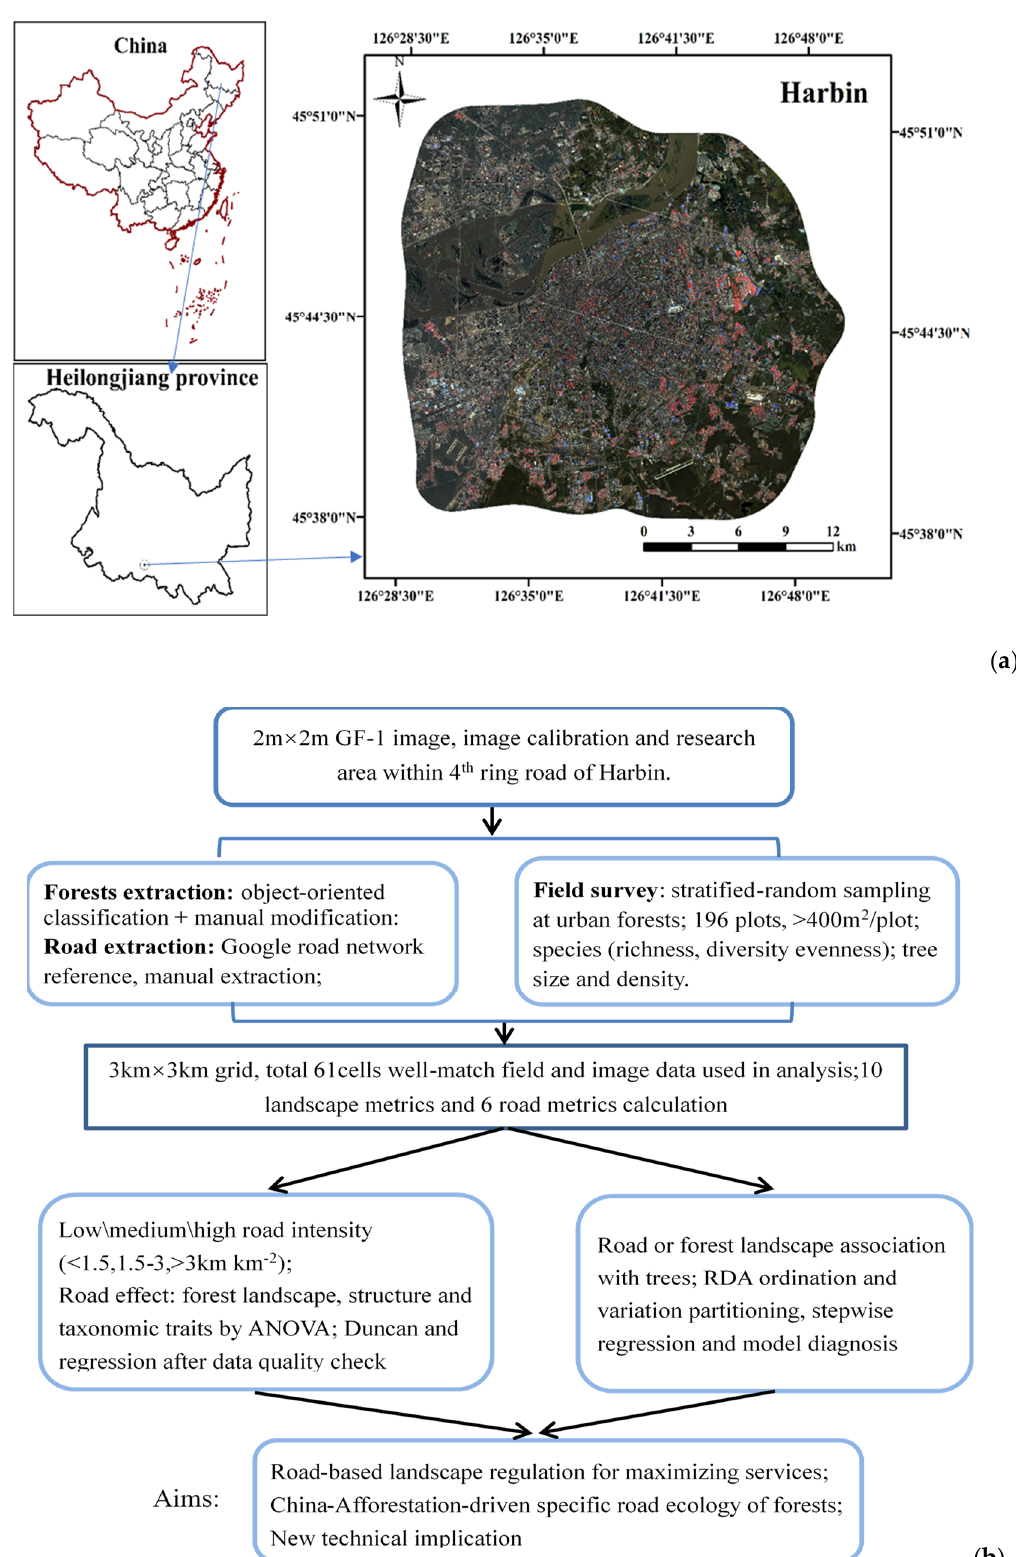
Figure 1. Location of the studied Harbin city ( a ) and main processes of road and forest landscape data extraction ( b ). Abbreviations: Gaofen No.1 remote sensing image (GF-1 image), Redundancy analysis (RDA), Analysis of variance (ANOVA).